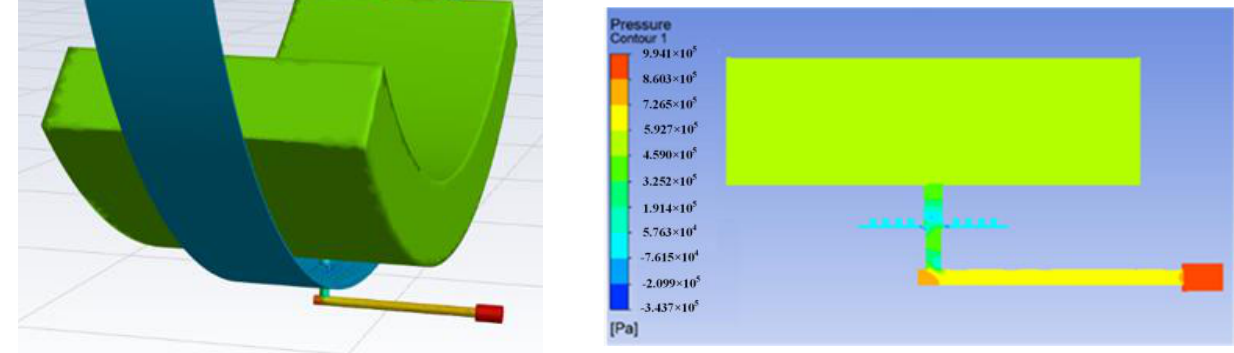
Figure 8. Fluid domain model and pressure distribution nephograms of intermediate sections.